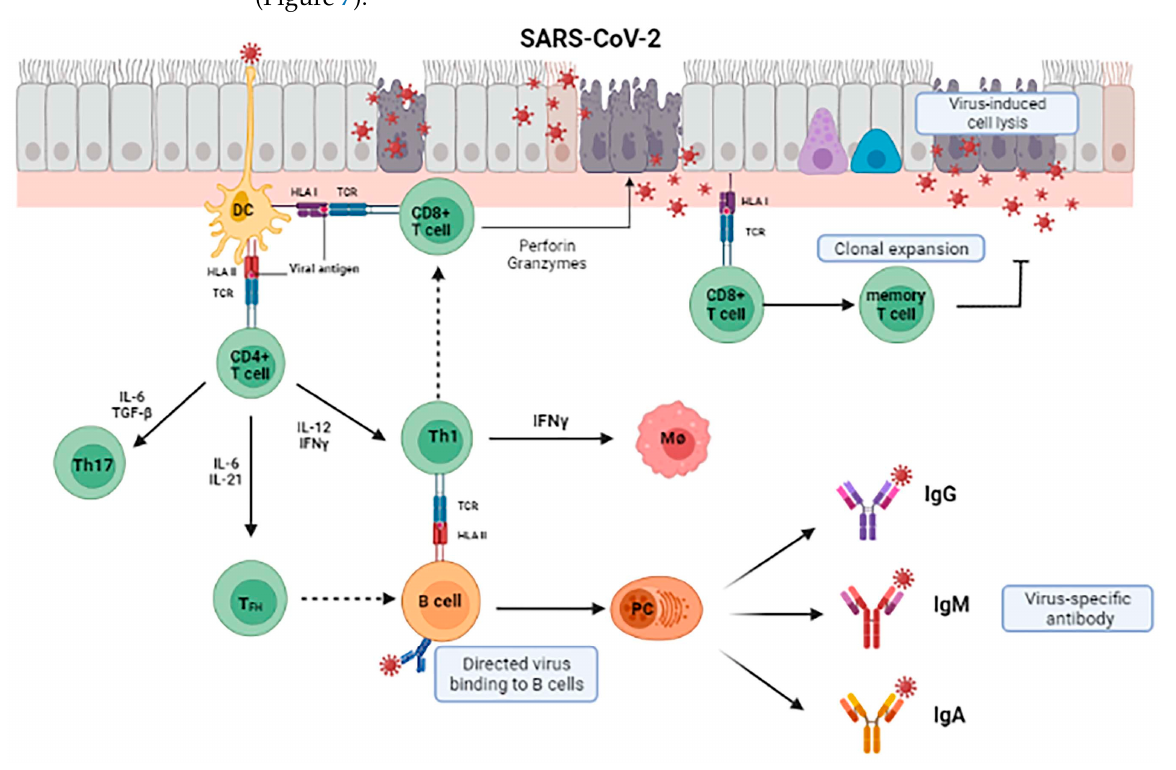
Figure 7. Adaptative immune response during SARS-CoV-2 infection. CD8+ T lymphocytes cytotoxicity is induced by recognition of viral antigens expressed on infected epithelial cells. Subepithelial dendritic cells (DC) recognize present SARS-CoV-2 antigens to CD4+ T lymphocytes, inducing IFN- γ secretion and their differentiation toward memory T helper 1 lymphocytes (Th1), T helper 17 lymphocytes (Th17), and T follicular helper (TFH). TFH helps B cells to develop into plasmacells (PC) and promote the production of IgM, IgA, and IgG isotype SARS-CoV-2-specific antibodies, while Th1, once activated by B cell antigen presentation, activate naïve monocyte (M ∅ ), through IFN- γ secretion.